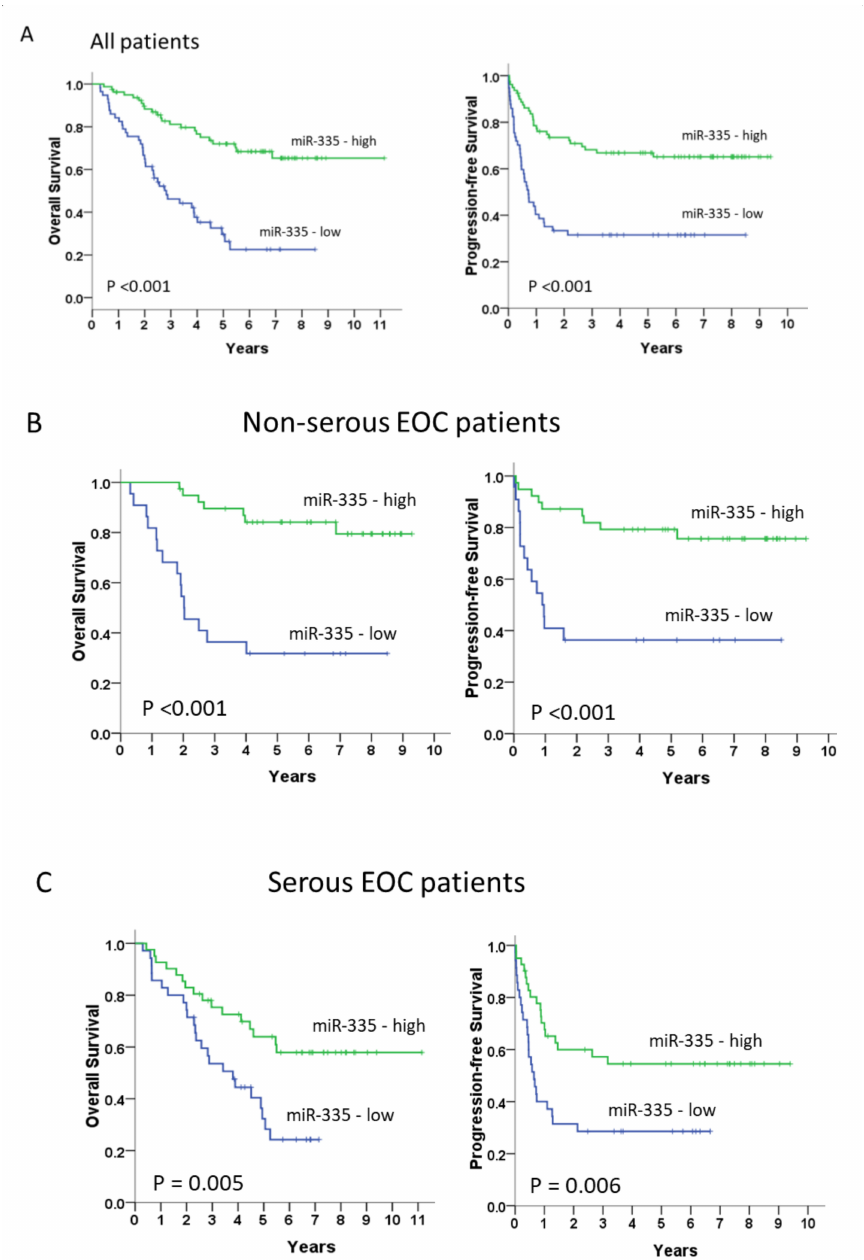
Figure 4. Long-term overall and progression-free survivals ( A ) in all patients ( n = 137) and the non-serous ( n = 61) ( B ) and serous subgroups ( n =76) ( C ). Kaplan–Meier curves, stratified by the miR-335 messenger RNA level and assessed by log-rank